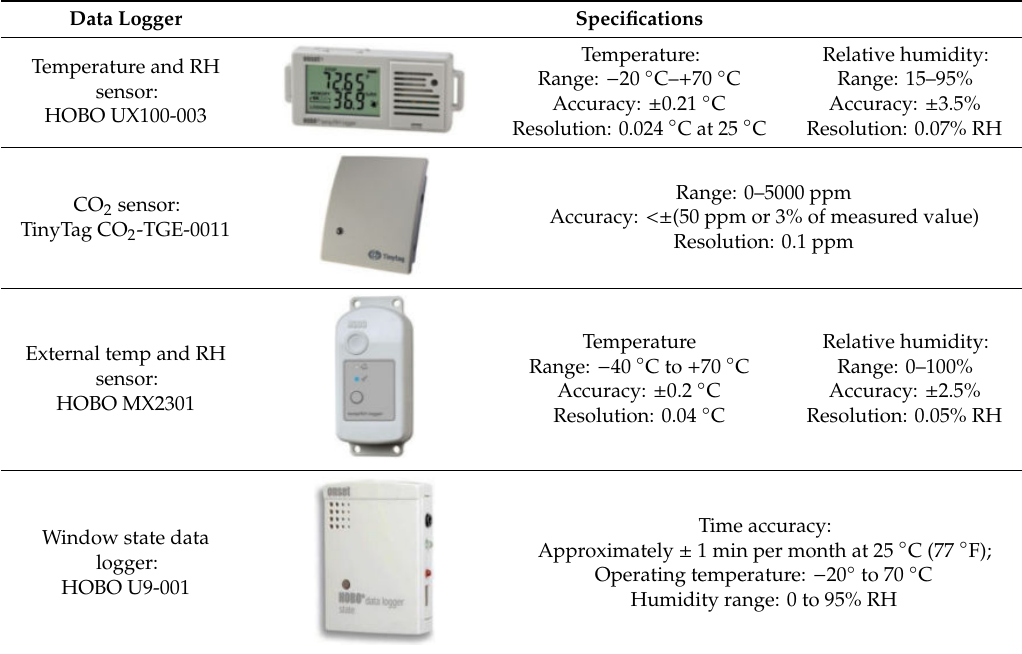
Table 5. Specification of data loggers used in the monitoring study.